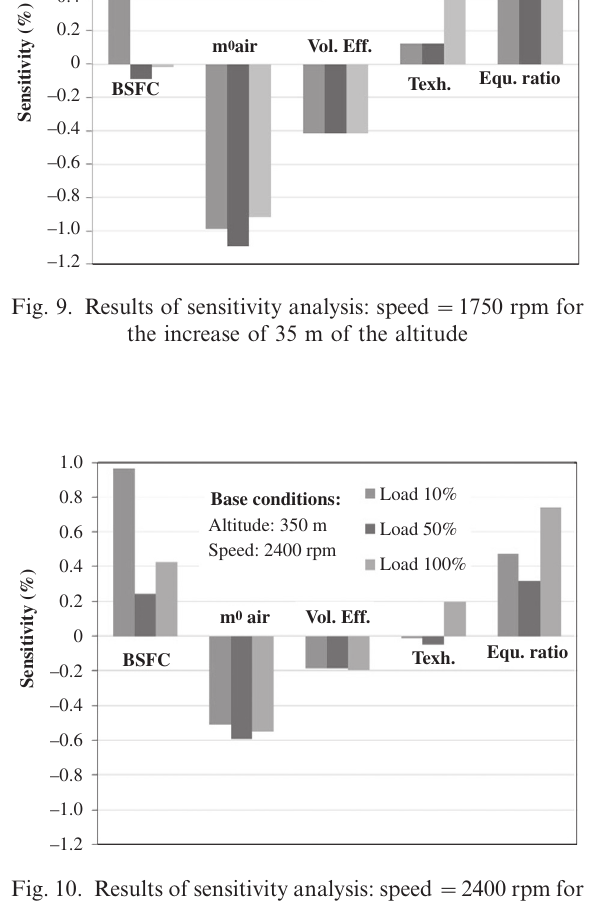
Fig. 10. Results of sensitivity analysis: speed (cid:4) 2400 rpm for the increase of 35 m of the altitude